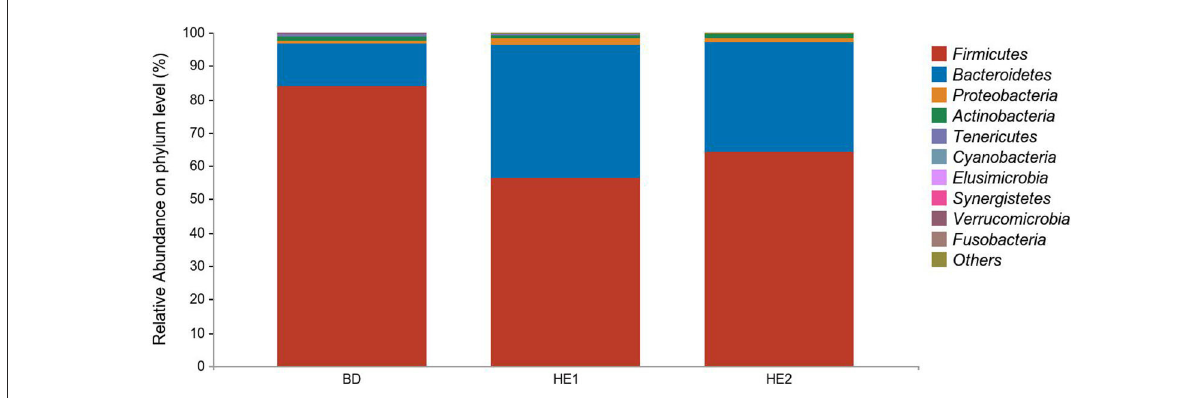
FIGURE1 Relative abundance at the phylum level between groups.